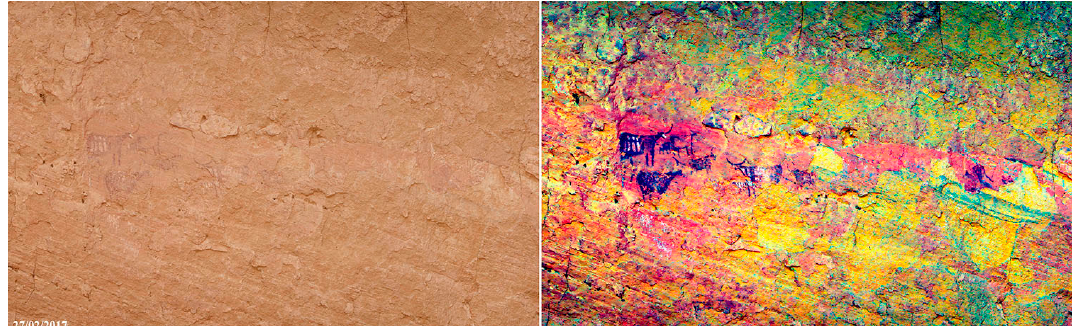
Figure 13. Remains of bicolour cattle figures at 4.5 m above shelter floor at P8 (Photo: Alessandro Menardi Noguera). The enhanced version of the picture to the right shows a fragmentary figure of a warrior with a large round shield, right of the cattle figures (DStretch LDS colour space).